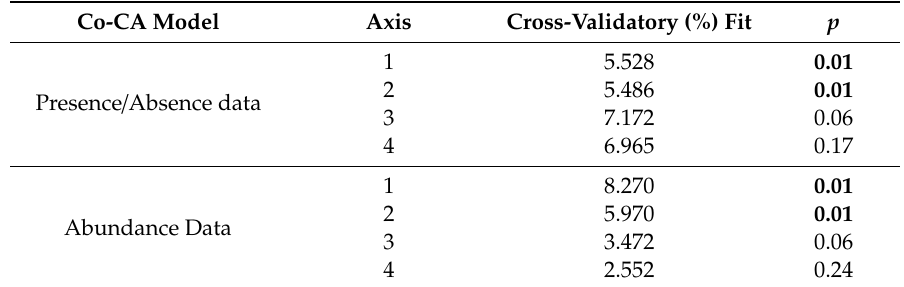
Table 4. Significance of Co-CA axes for lichens and plants considering both presence / absence and abundance data. Significant cross-validatory fit is shown in